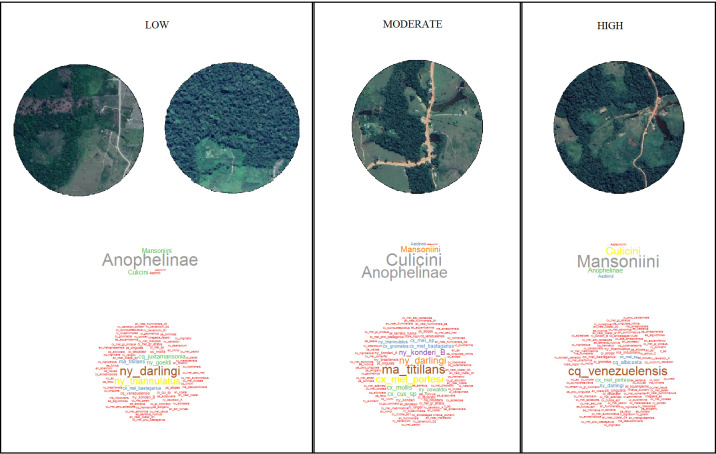
Culicidae species frequency displayed as a cloud for each of three ED categories (low, moderate and high) in forest fringe collections in rural areas of Amazonian Brazil.Font size is proportional to the frequency of Culicidae species. Edge density categories: Low (0–1.5 m / ha x 100); moderate (1.5–2.0 m / ha x 100); high (2.0–3.5 m / ha x 100).